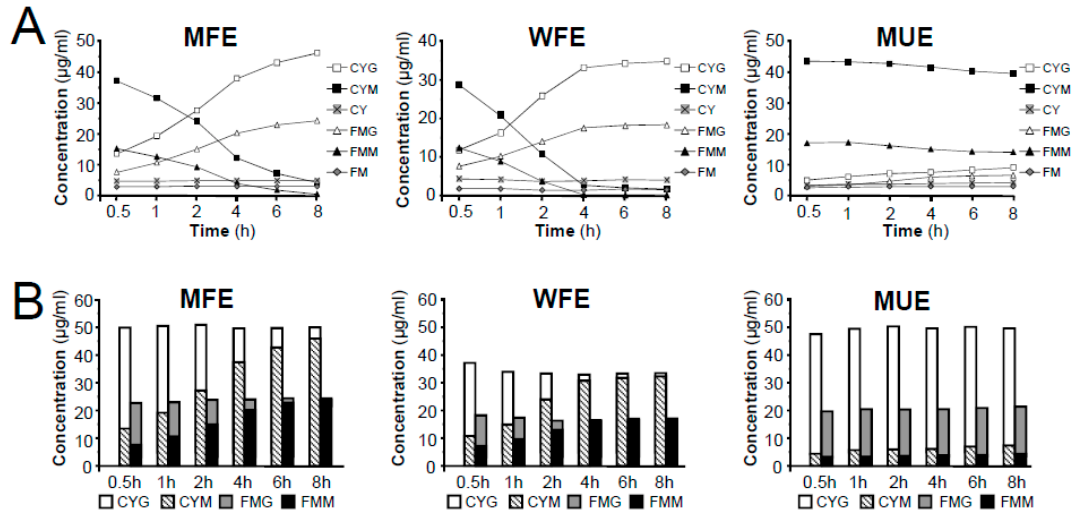
Figure 5. Comparison of extraction efficiency of different methods on the extraction of MIGs, related glycosides and aglycones in Astragali Radix. ( A ) Effects of extraction time on the extraction efficiency of six isoflavonoids in three different methods (MFE, WFE and MUE). ( B ) Effects of extraction method and time on the conversion of the content of matched-constituents (CYG-CYM and FMG–FMM).